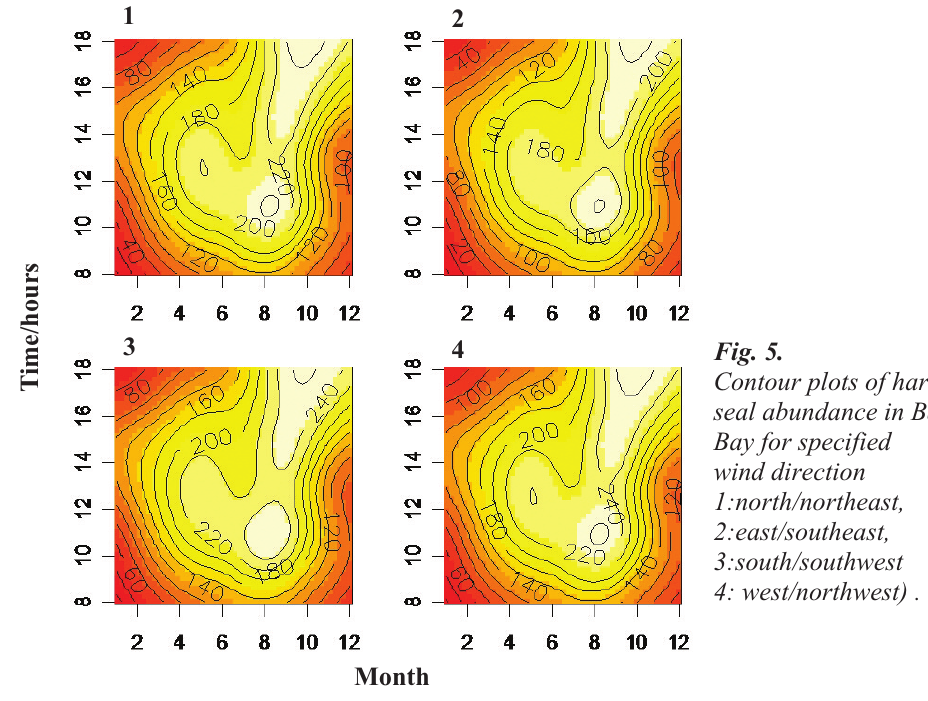
Fig. 5. Contour plots of harbour seal abundance in Bantry Bay for specified wind